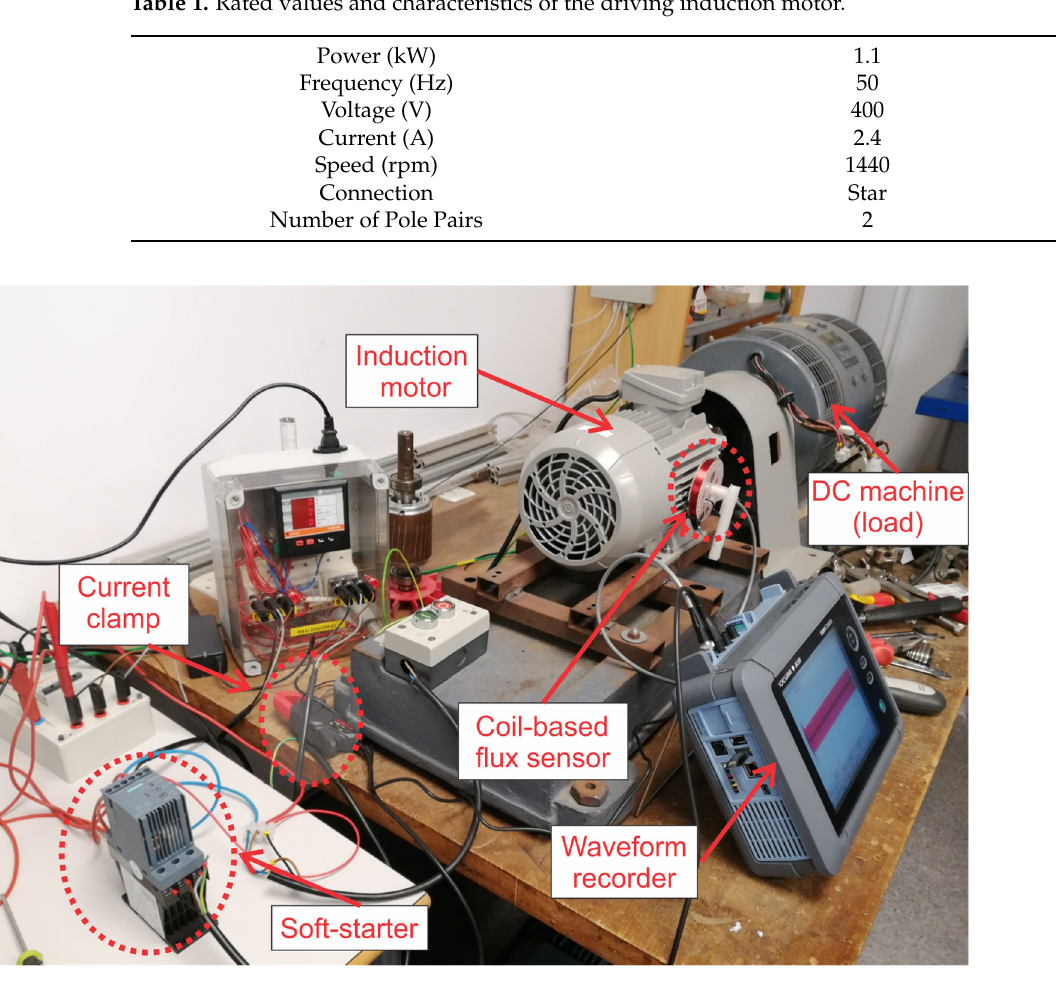
Figure 7. Shape and dimensions of the coil sensor used during the experiments. Additionally, the machine was started by using four different soft-starters from dif- ferent manufacturers (see Figure 8). The characteristics of the different soft-starters used are shown in Table 2. In this way, several tests were carried out using different levels of